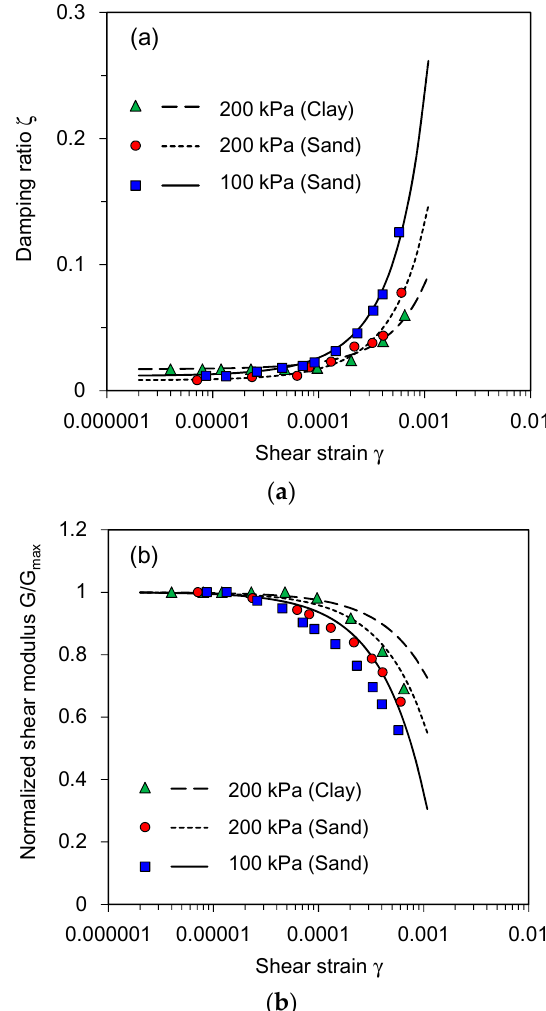
Figure 3. Strain-dependent behavior of sand and clay under different confinement stress levels: ( a ) Damping ratio and ( b ) Secant shear modulus. The symbols are experimental data and the lines are defined by Equations (8) and (4). The symbols are experimental data [31].